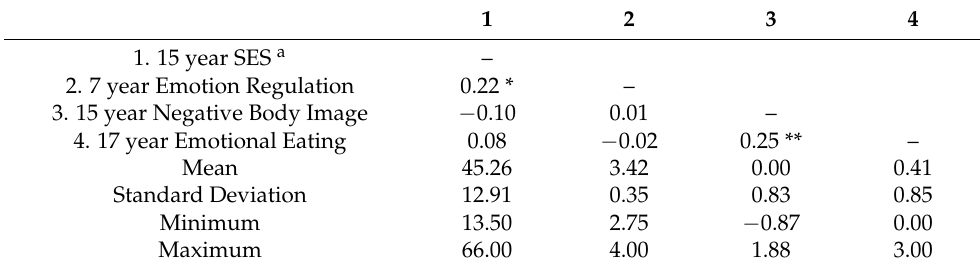
Table 1. Bivariate correlations and descriptive